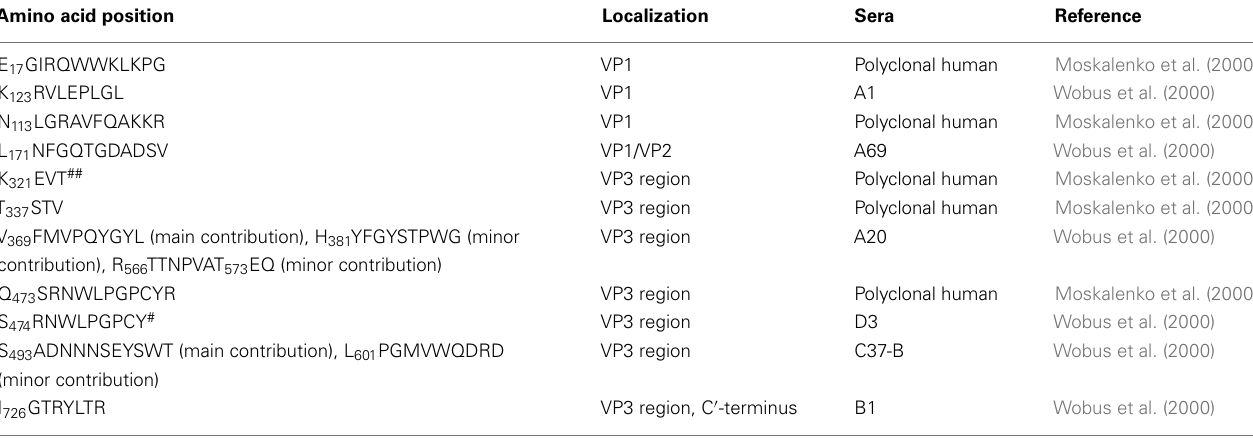
Table 1 | Immunogenic sites of theAAV2 capsid mapped by peptide